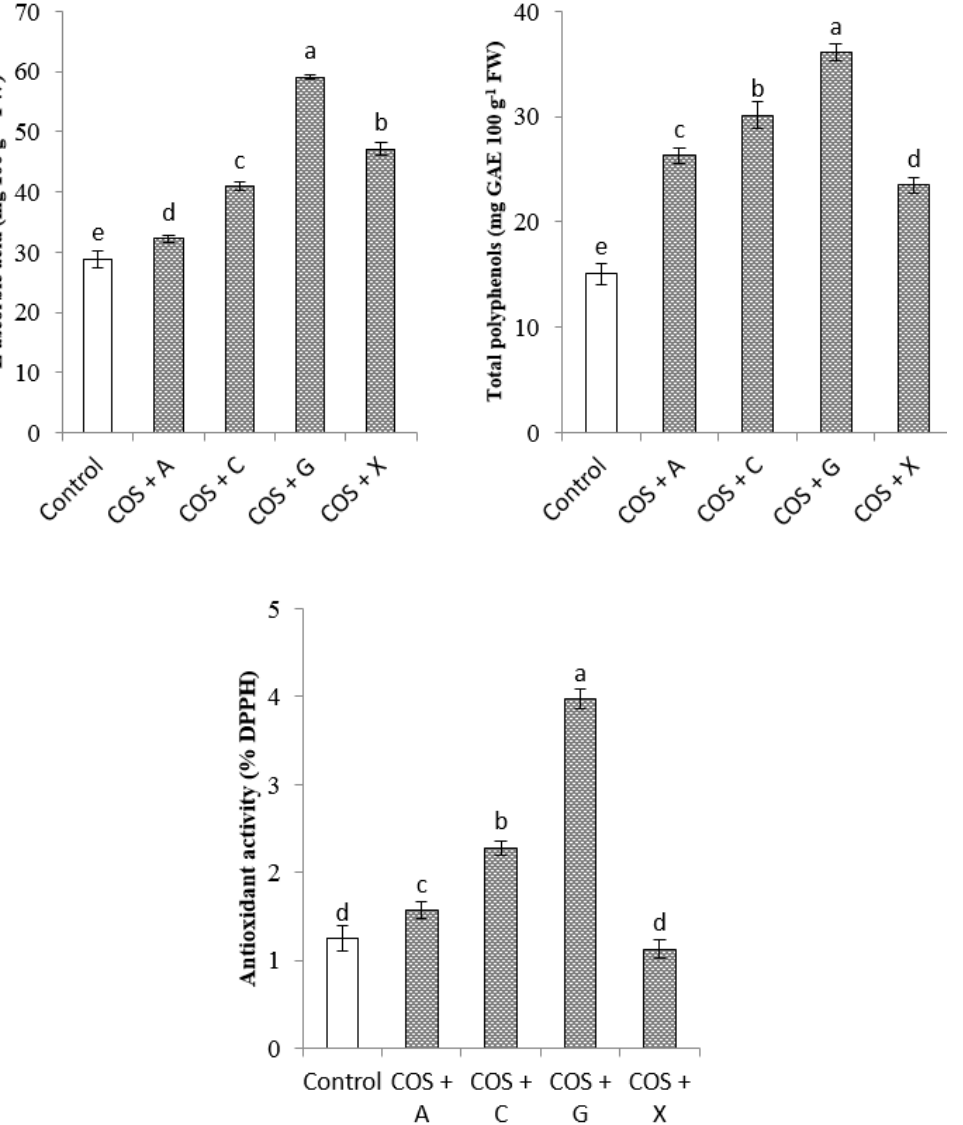
Figure 2. Effects of COS coating combined with selected ionic polymers on content of L -ascorbic acid, total polyphenols and antioxidant activity of Ornithogalum saundersiae . Treatments: Non-coated bulbs (Control); COS + alginic acid sodium salt from brown alga (COS + A); COS + carrageenan iota (COS + C); COS + gellan gum (COS + G), COS + xanthan gum (COS + X). All data are means ± standard deviation (vertical bars). The columns with the different letters indicate significant differences ( p ≤ 0.05).